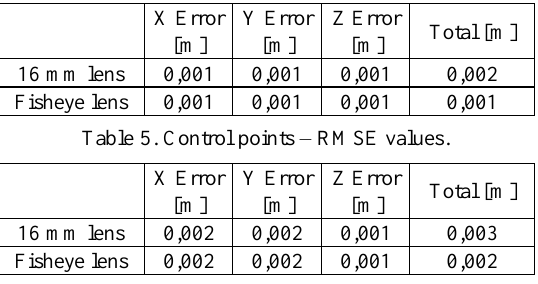
Table 5. Control points – RMSE values.